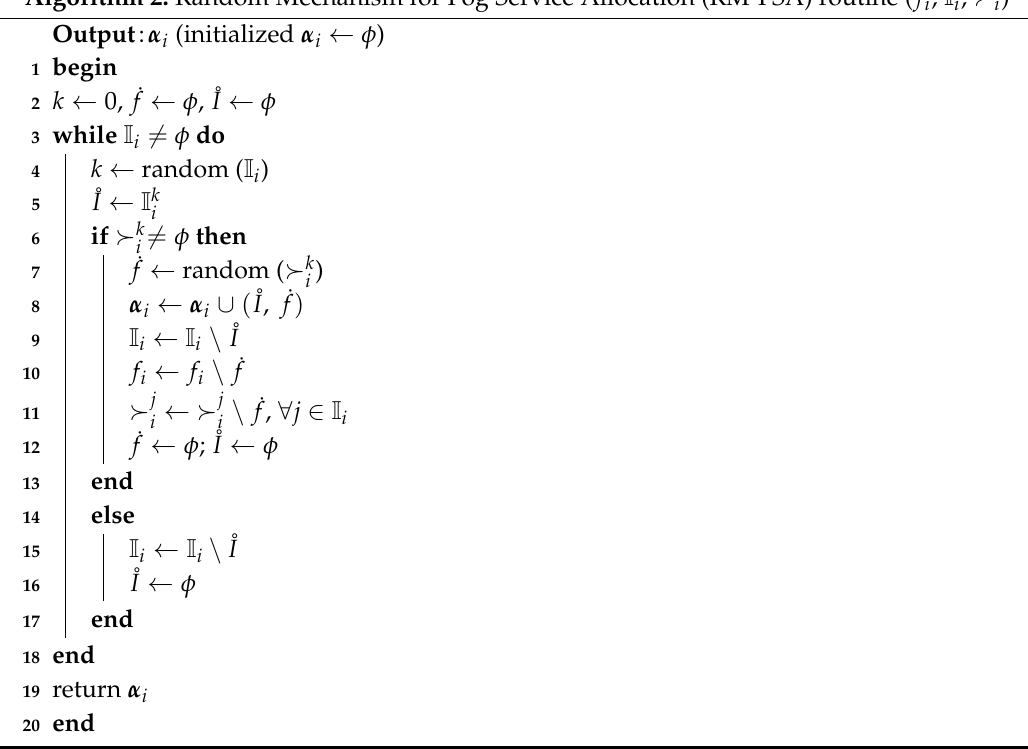
Algorithm 2: Random Mechanism for Fog Service Allocation (RM-FSA) routine ( f i , I i ,